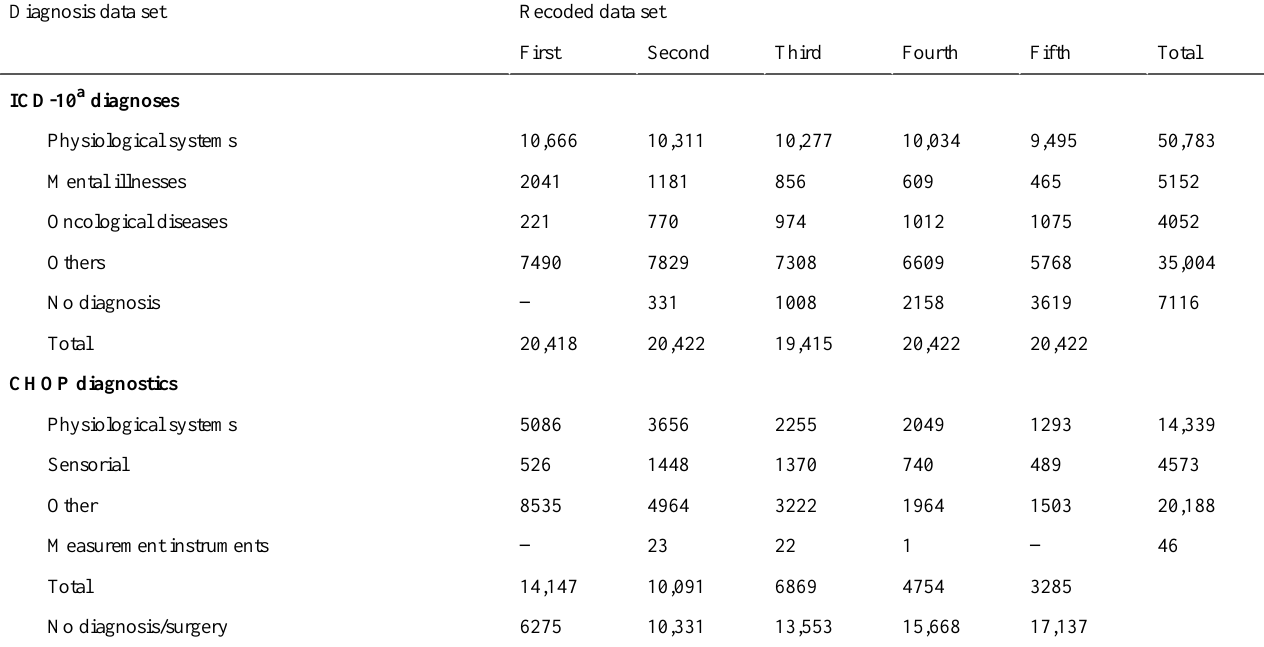
Table 6. Distribution of the recoded data set using the ICD-10 and CHOP diagnoses (N=20,422). Recoded data setDiagnosis data set